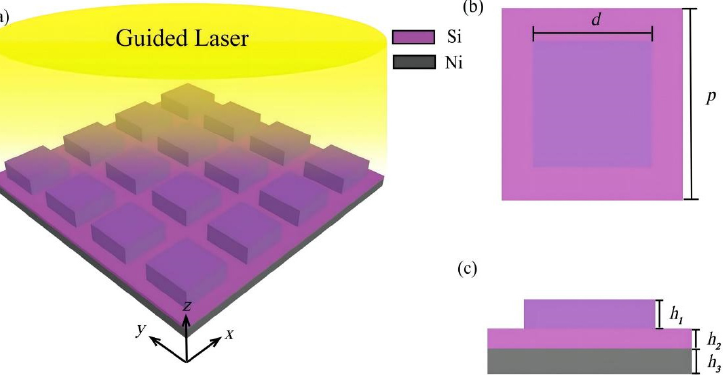
Figure 1. Schematic diagram of the metasurface. ( a ) 3D view of the metasurface. ( b ) Top view of each unit cell. ( c ) Side view of each unit cell. When the metasurface is illuminated by a laser, surface plasmon polaritons (SPPs) could be excited. According to the wavevector matching theory [22,23], whether or not to excite the SPP is controlled by: